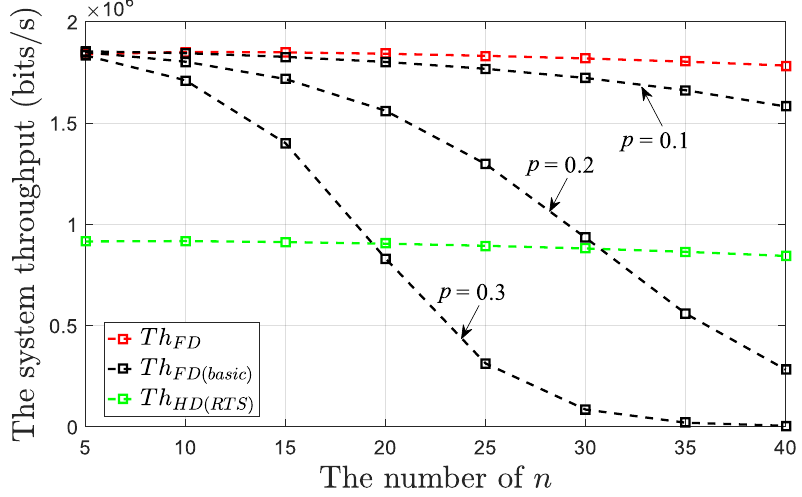
Figure 10. System throughputs for the proposed FD MAC protocol and the MAC protocol in [5] with fixed transmission probability versus the different value of n ( W = 32).